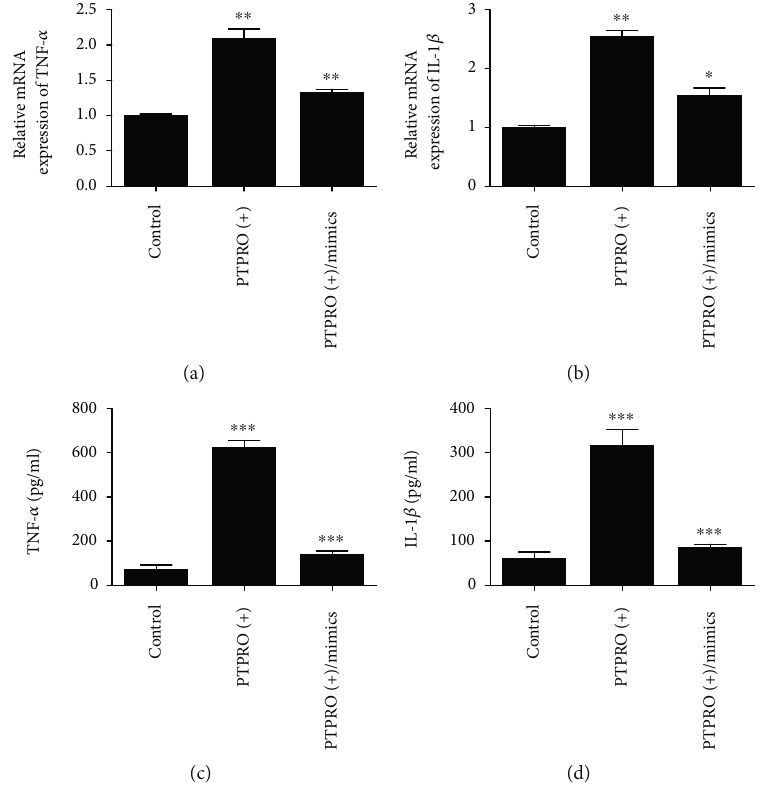
Figure 4: MiR-6869-5p prevented from the production of TNF- α and IL-1 β in macrophages (compared with the control group, ∗∗ P < 0 : 01 , ∗∗∗ P < 0 : 001 ; compared with the PTPRO (+) group, ∗ P < 0 : 05 ; ∗∗ P < 0 : 01 ; ∗∗∗ P < 0 : 001 ). (a) mRNA expression of TNF- α . (b) mRNA expression of IL-1 β . (c) TNF- α in the supernatant of macrophages. (d) IL-1 β in the supernatant of macrophages.